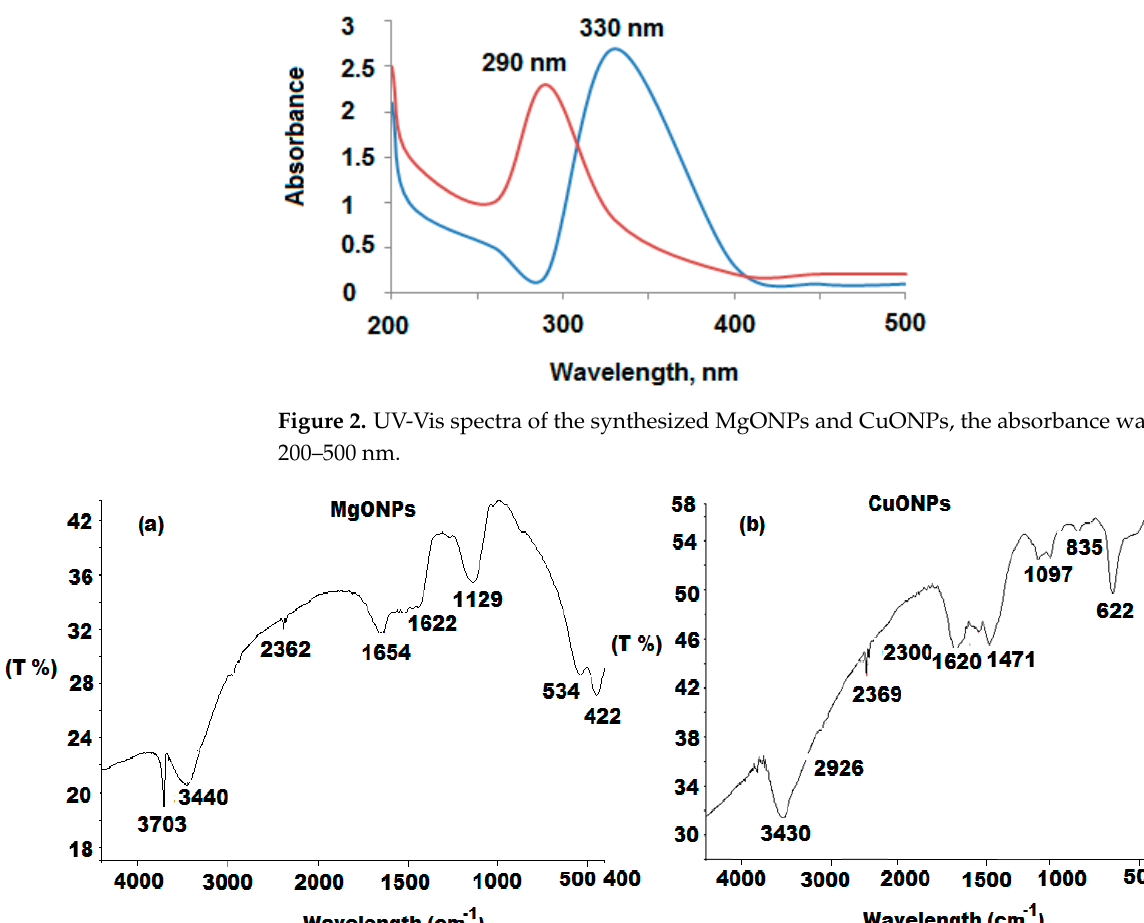
Figure 3. FT-IR spectra of synthesized ( a ) MgONPs and ( b ) CuONPs at a wavenumber range from 4000 to 400 cm − 1. For CuONPs, two well defined bands at 3430 and 2926 cm − 1 were observed and were